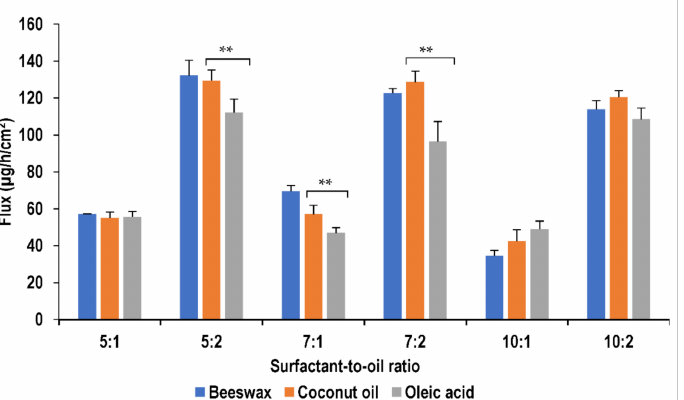
Figure 7. Effect of oil type on flux of lidocaine nanoemulsion through PDMS membrane (** p >